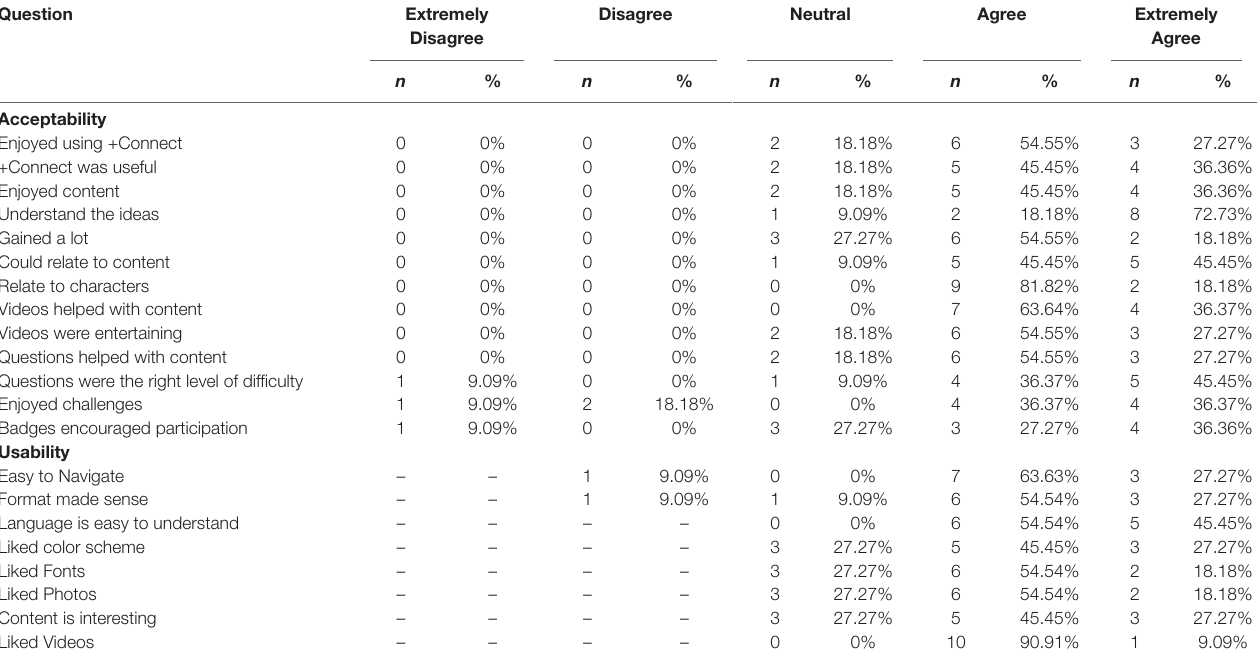
TABLE 7 | Ratings related to functionality, design, and delivery of concepts for the student